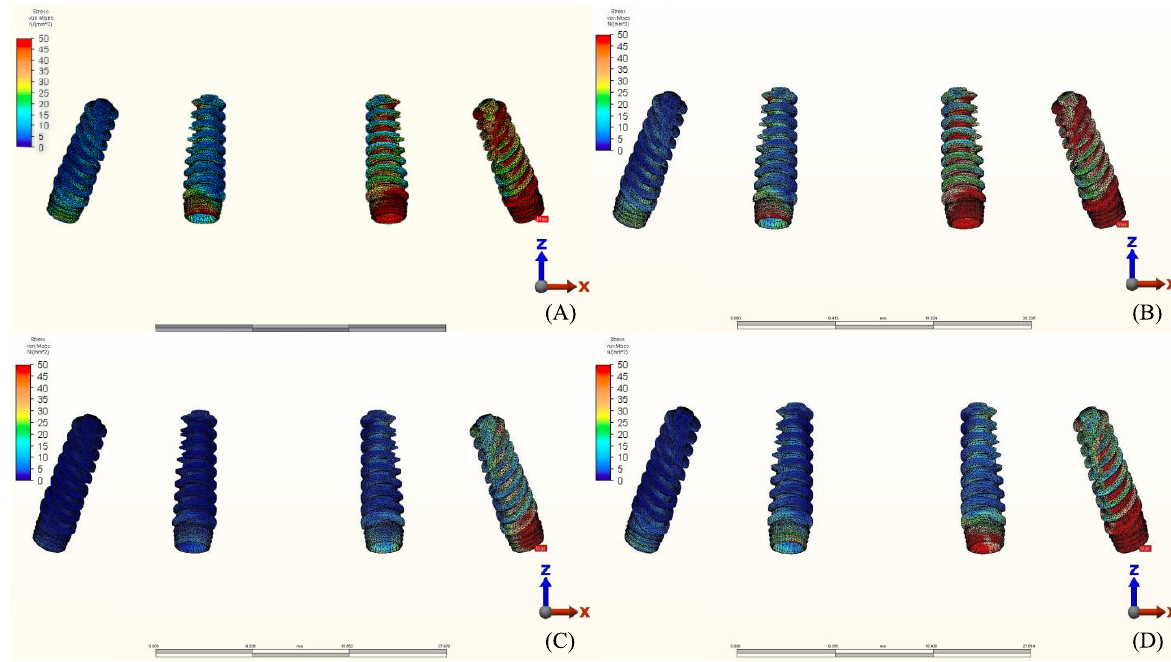
Figure 13. Implant stress distribution for group 1, titanium bar with acrylic teeth. ( A ) Model 1.1, opposing natural tooth. ( B ) Model 1.2, opposing tooth-supported full ceramic crown. ( C ) Model 1.3, opposing acrylic prosthesis with titanium framework. ( D ) Model 1.4, opposing implant-supported full ceramic crown.